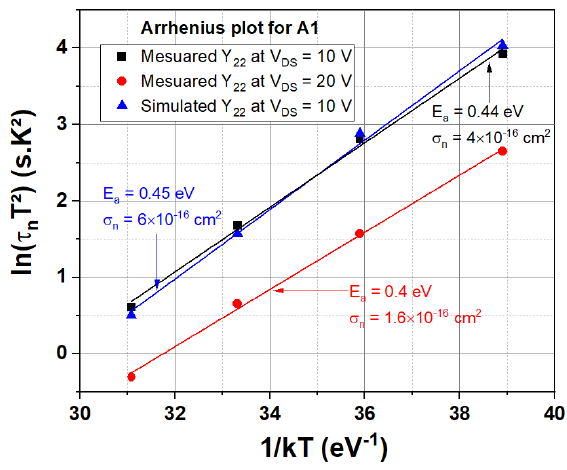
Figure 13. Arrhenius plots for the trap A1 obtained from the measured Y 22 parameters at V DS = 10 V and 20 V are shown along with the simulation case at V DS = 10 V. and 20 V are shown along with the simulation case at V DS = 10 V.